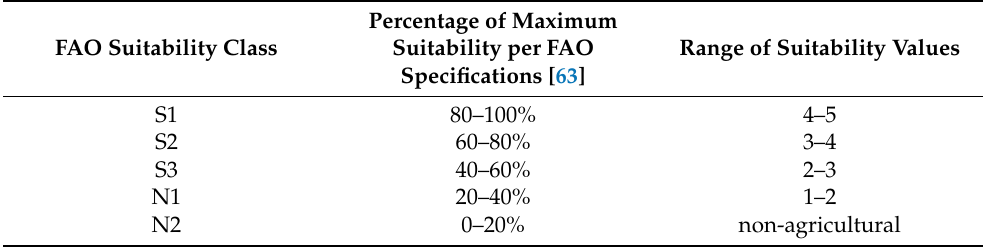
Table 3. Designation of FAO suitability classes according to suitability values obtained after machine learning